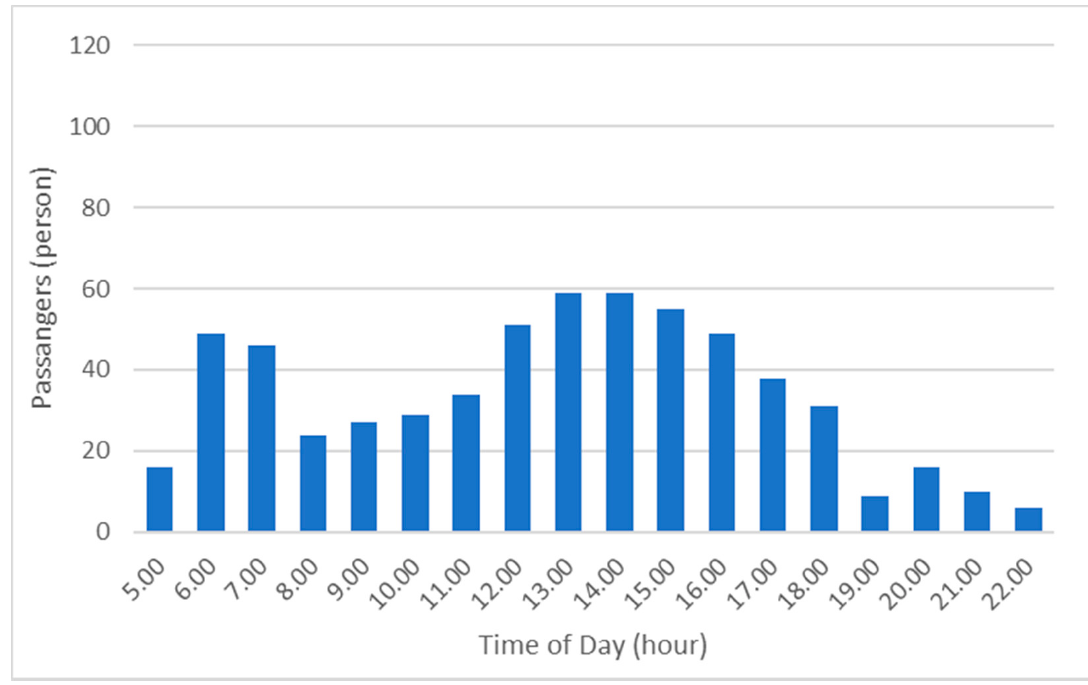
Figure 11. Passengers on one bus shift (11 July 2019).